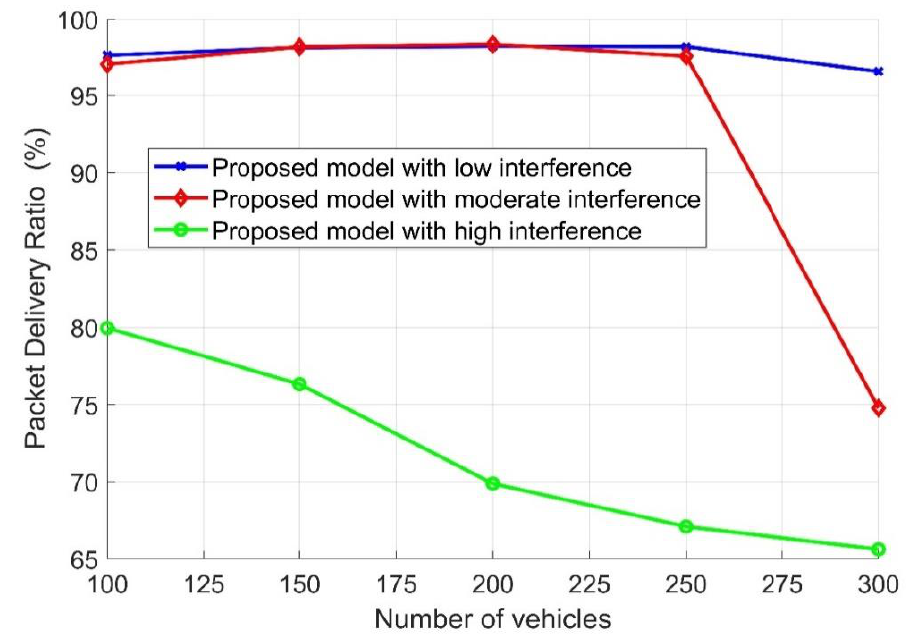
Figure 7. Packet delivery ratio versus the number of vehicles.